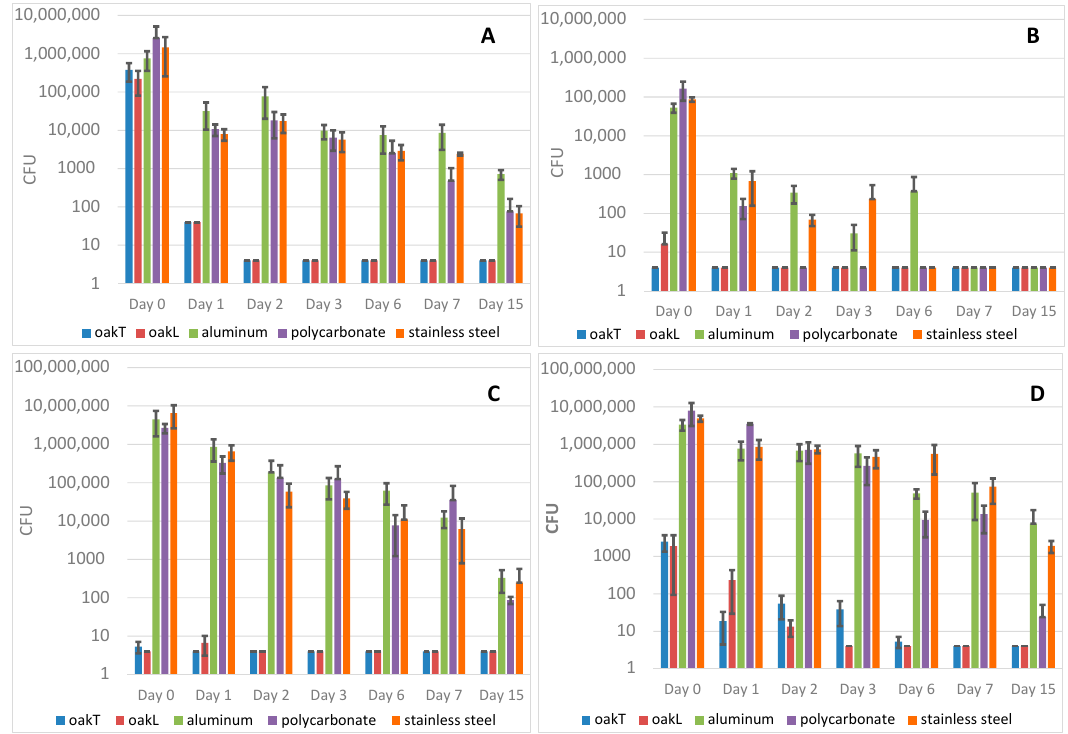
Figure 1. Average Colony Forming Units (CFU) of Klebsiella pneumoniae ATCC 700603 ( A ), Acinetobacter baumannii ATCC 19606 ( B ), Enterococcus faecalis ATCC 51299 ( C ) and Staphylococcus aureus KSKS7326 ( D ) on five materials. Blue bars represent transversal oak, orange bars represent tangential oak, grey bars represent aluminum, yellow bar represent polycarbonate and green bars represent stainless steel. The black lines represent the standard deviation (SD). Y axis: bacterial CFU. X axis: day of determination of the viable counts.